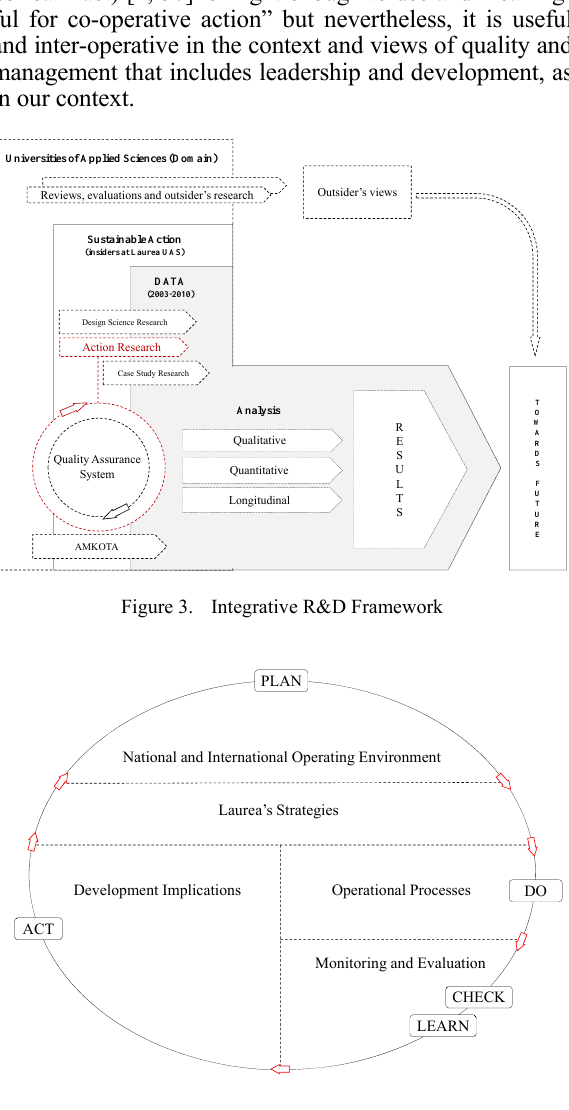
Figure 4. Steps of Quality Assurance in Integrative R&D